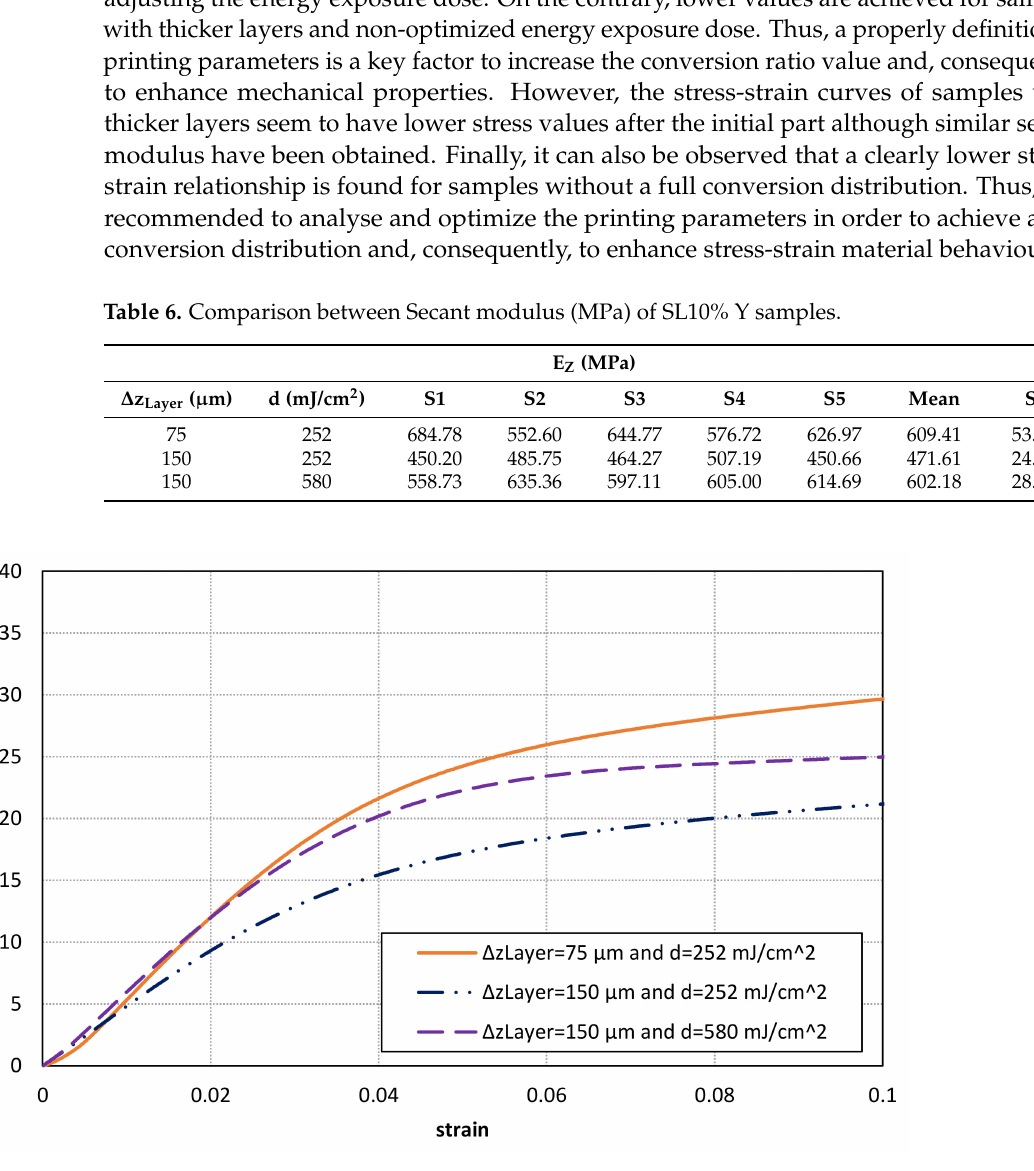
Figure 16. Comparison of stress-strain curves for the photocurable material SL10% according to the printing